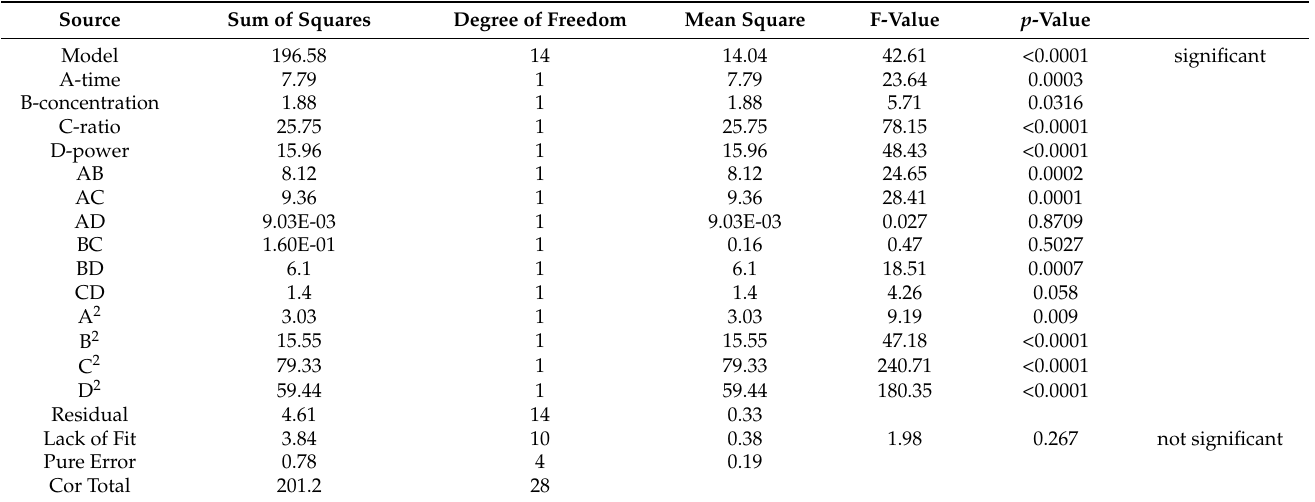
Table 3. Analysis of variance (ANOVA) for response surface quadratic model. Source Sum of Squares Degree of